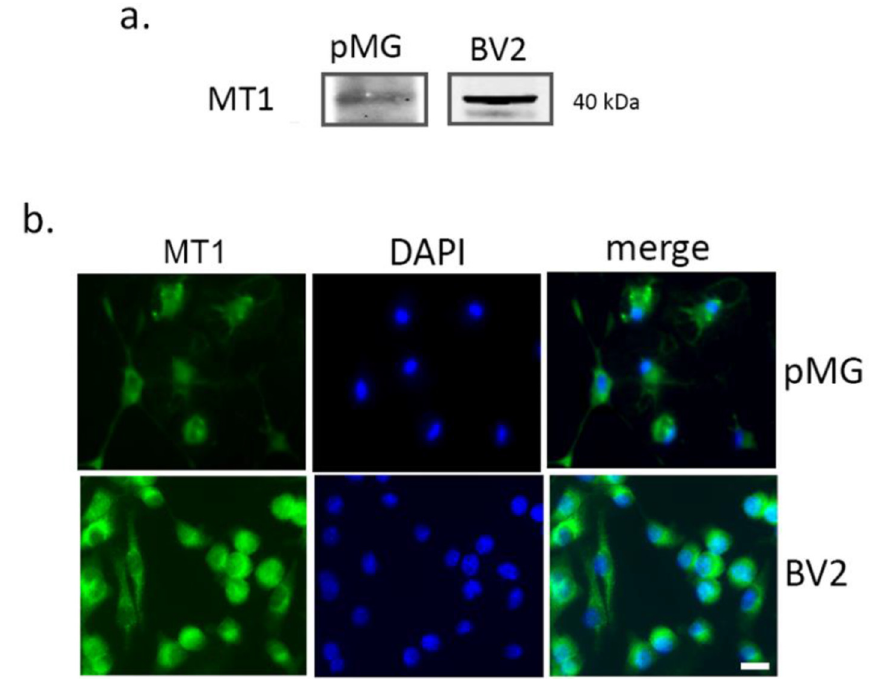
Figure 2. Melatonin receptor 1 (MT1) is expressed on microglial cells. Western blot ( a ) and immunocytochemical analysis ( b ) of the MT1 receptor in primary microglia (pMG) and BV2 cell line. Representative images are shown. Scale bar = 20 μ m.